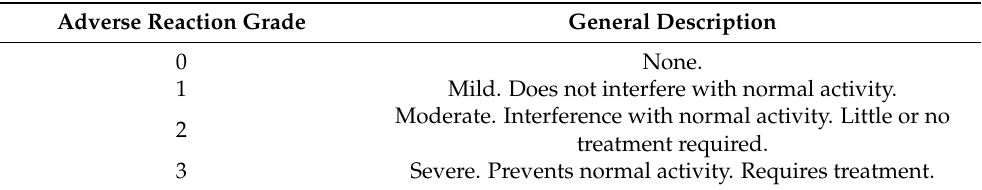
Table 1. Description of the assumed grades of adverse events. These follow the gradings described in [30,31].